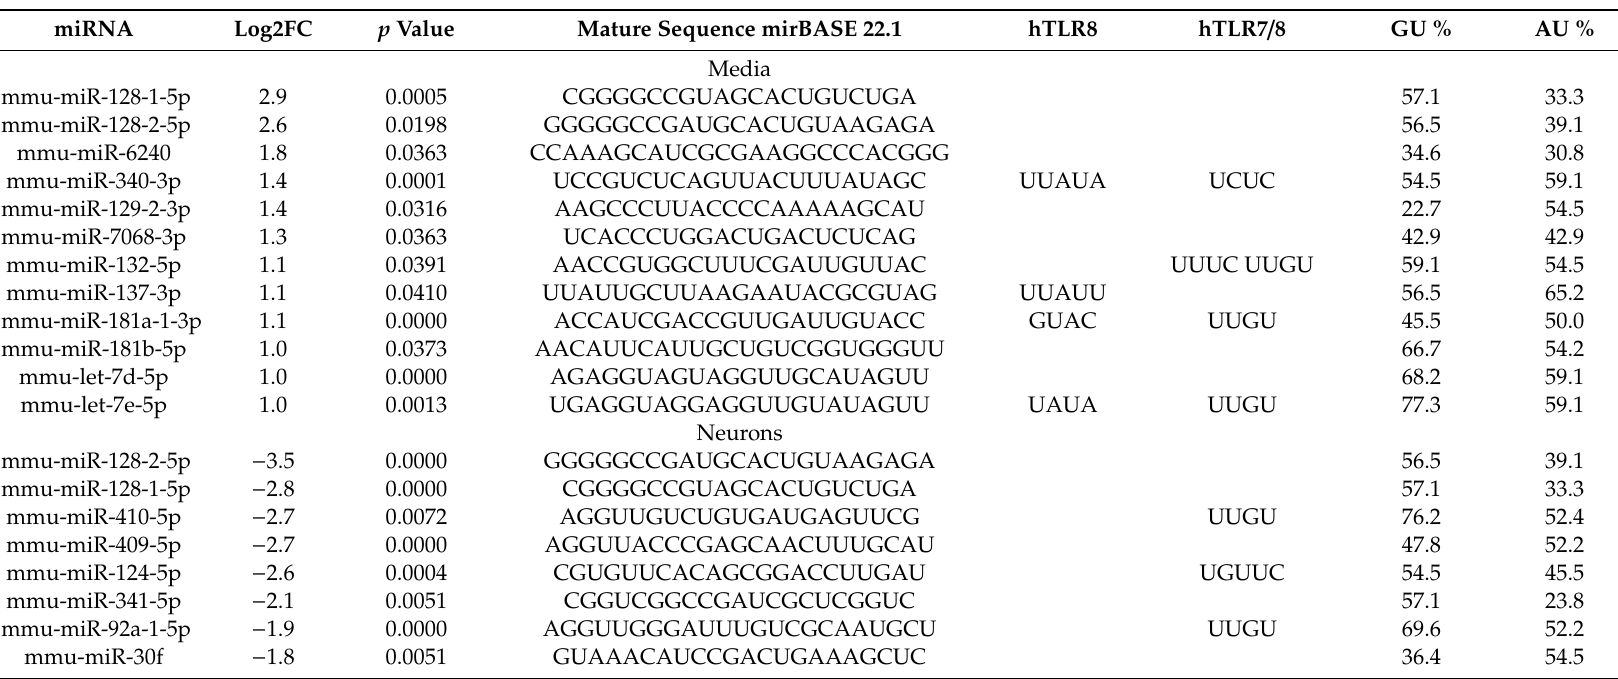
Table 1. TLR7 / 8-activating microRNA (miRNA) candidates. Depicted are miRNA candidates enriched in the supernatant (log2FC ≥ ± 1.0, p < 0.05) and miRNA candidates less present in neurons (log2FC > ± 1.5, p < 0.05). miRNA family members are highlighted in grey. miRNAs contain hTLR8- and hTLR7 / 8-activating sequence motifs, as described by Forsbach et al. [4]. GU or AU content of individual miRNAs is given in